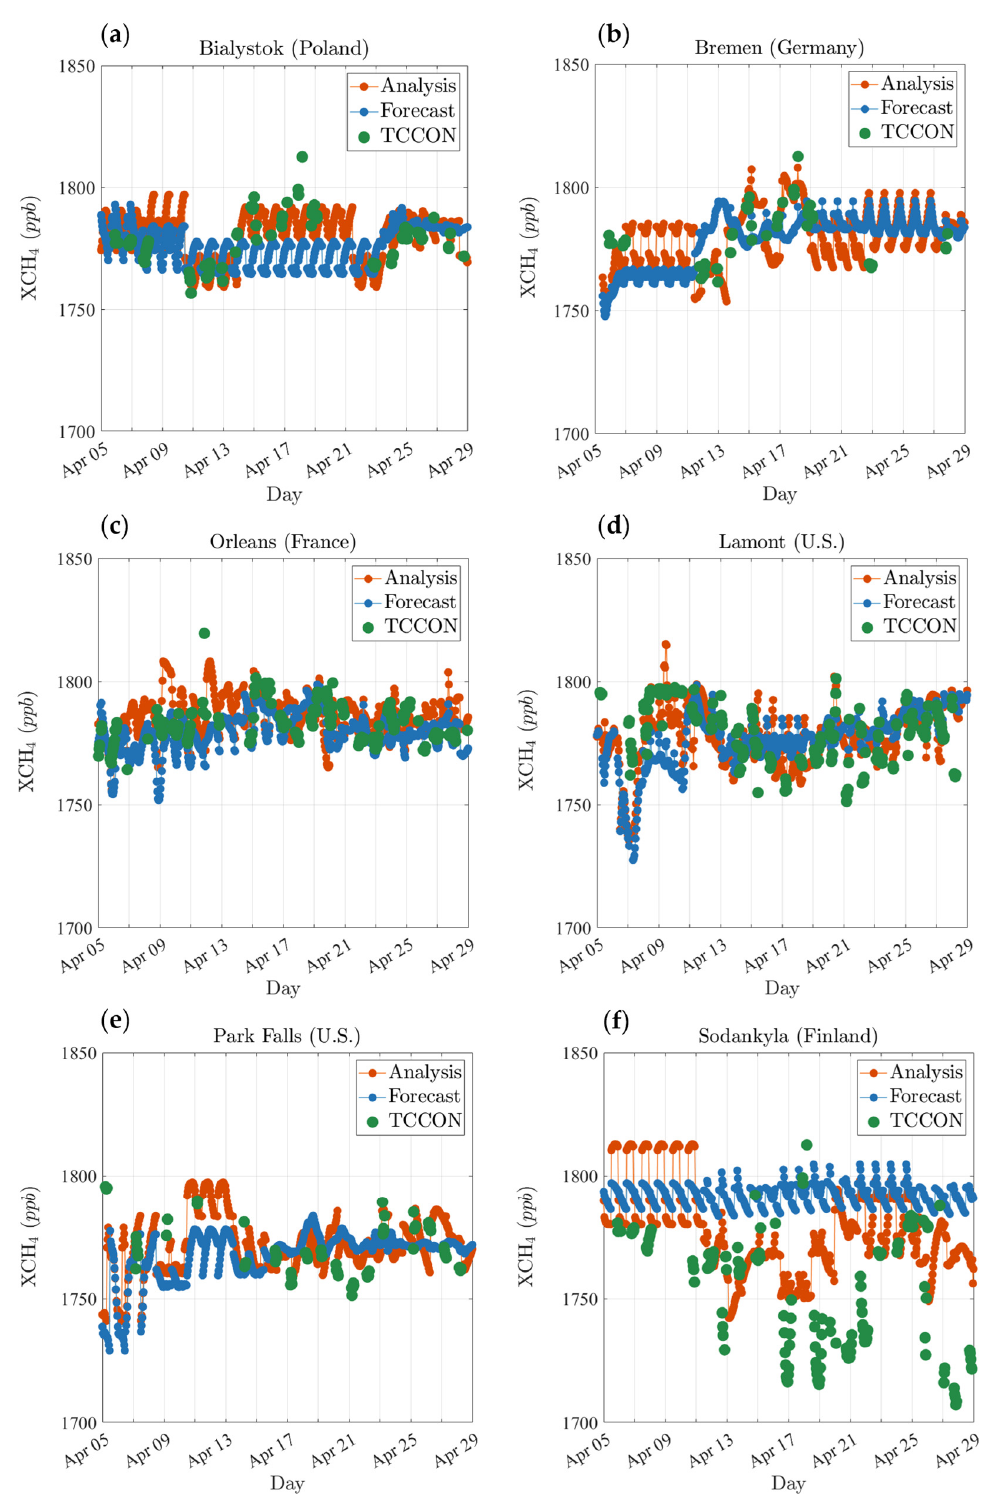
Figure 12. Comparison of the time series of the analysis (red dots) and the model (blue dots) against TCCON observations (green dots). Six TCCON observation sites (Figure 7—red circles) include ( a ) Bialystok (53.23 °N, 23.03 °E), ( b ) Bremen (53.10 °N, 8.85 °E), ( c ) Orleans (47.97 °N, 2.11 °E), ( d ) Lamont (36.60 °N, 97.48 °W), ( e ) Park Falls (45.95 °N, 90.27 °W), ( f ) Sodankylä (67.37 °N, 26.63 °E).